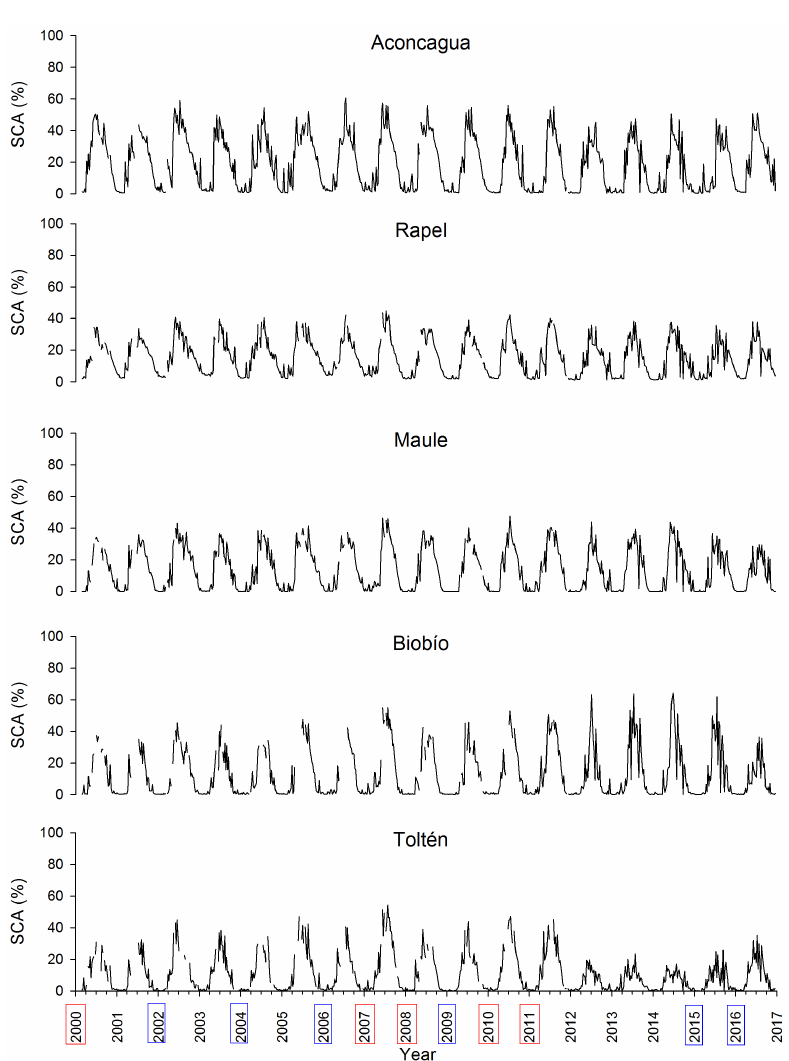
Figure 4. SCD for the 2000–2016 period at Aconcagua, Rapel, Maule, Biobío and Toltén watersheds. Red boxes indicate Niña years, blue ones Niño